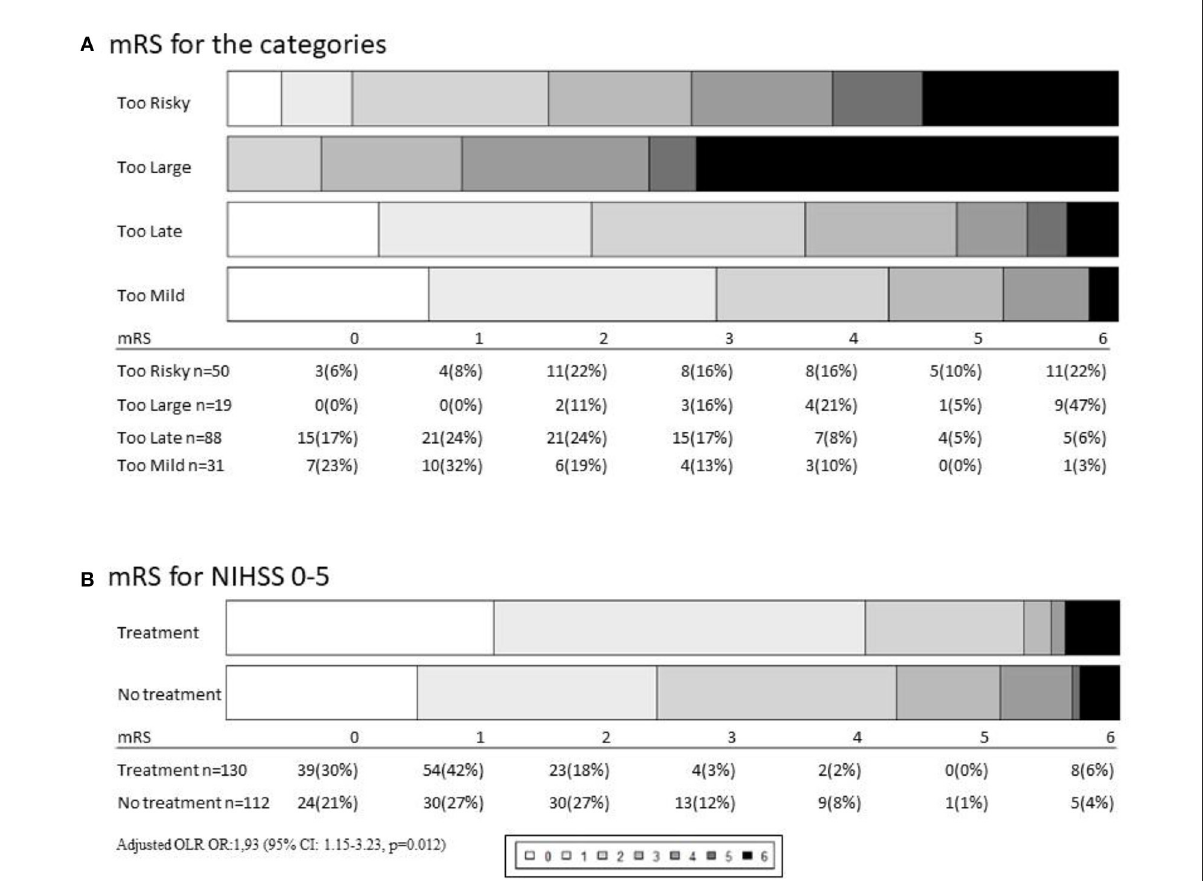
FIGURE4 (A) Outcomes depending on category measured by 90 days modified Rankin Scale score (mRS). Of 198 not-treated patients the mRS 6 patients were lost to follow up. (B) In the National institute of health stroke scale (NIHSS) 0–5 analysis 130 did get treatment with intravenous thrombolysis (IVT) and/or endovascular treatment (EVT) and 112 were not